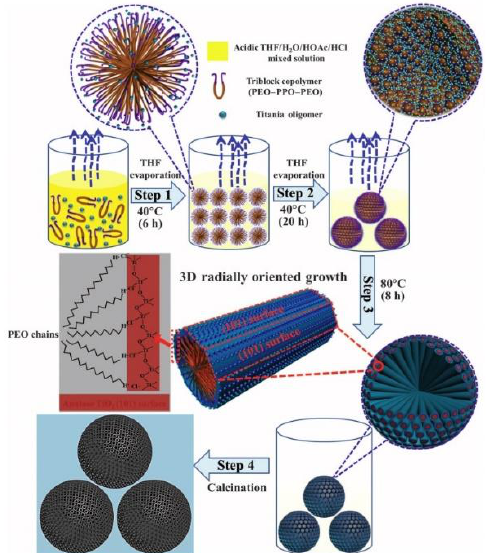
Figure 7. Schematic presentation of the formation process of mesoporous anatase TiO 2 microspheres with radially oriented hexagonal mesochannels and single-crystal-like pore walls through evaporation-driven oriented assembly. Reprinted with permission from [64]. Copyright American Chemical Society, 2015.